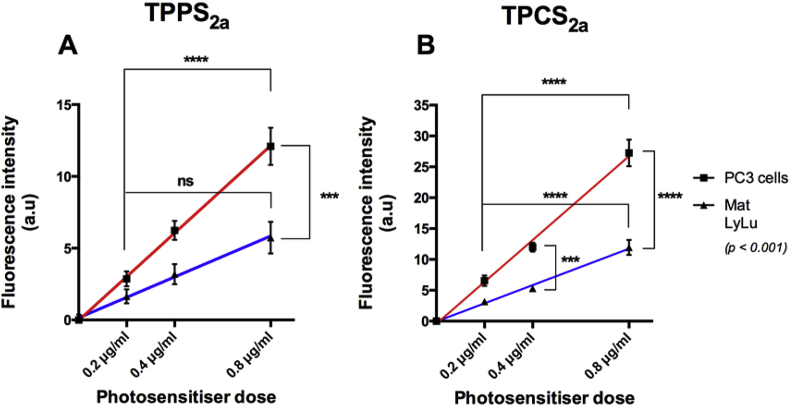
Uptake of TPPS2a& TPCS2ain PC3 and MatLyLu cells. PC3 and MatLyLu cells were exposed to increasing doses of photosensitiser (0.2 μg/ml – 0.8 μg/ml) during 24 h and uptake was related to fluorescence emission.